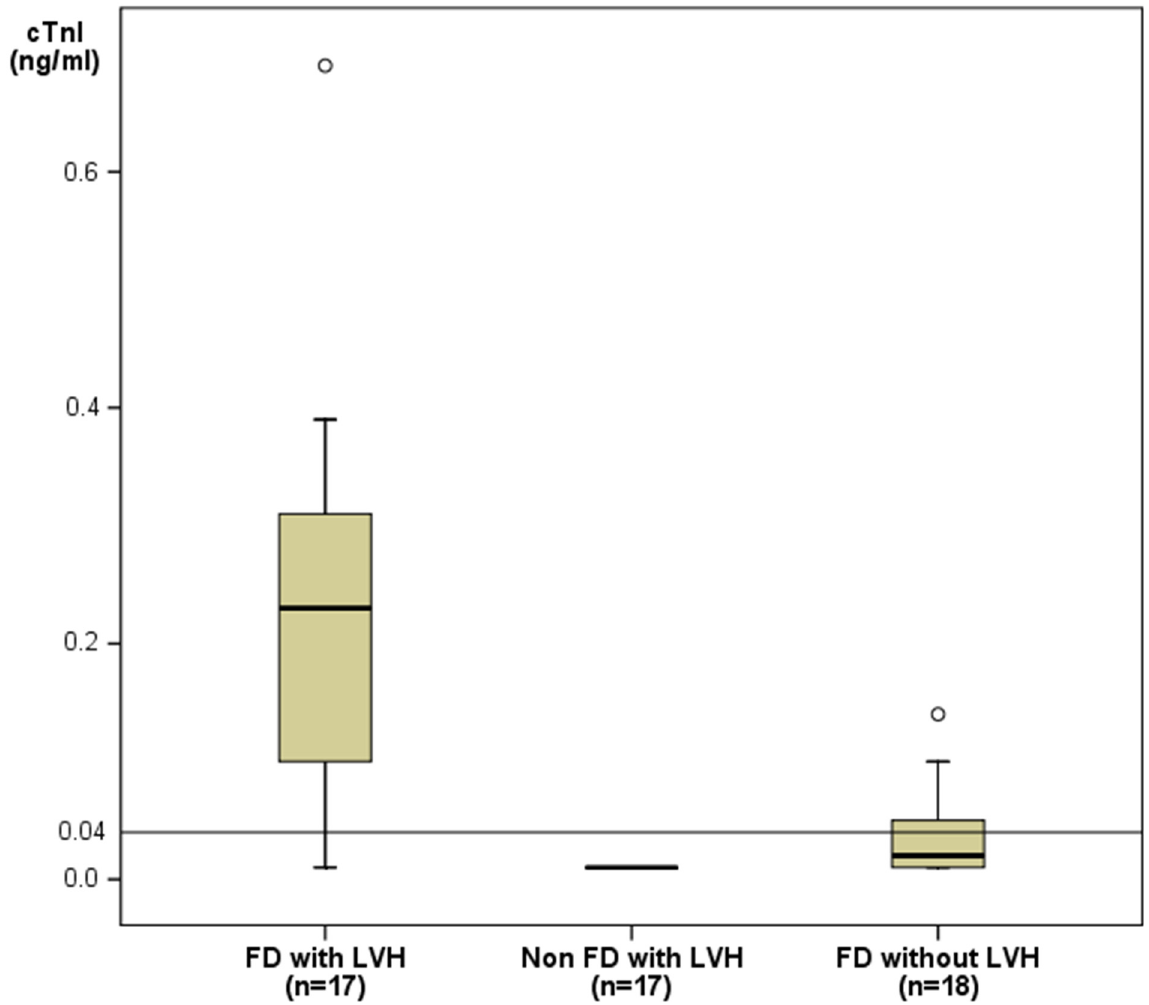
Fig 1. Comparison of cardiac troponin I levels. Presented are patients with Fabry disease (FD) and left ventricular hypertrophy (LVH) (n = 17) versus FD patients without LVH (n = 18) and non-FD patients with LVH of other cause (n = 17). The cut-off level for cTnI in diagnosing myocardial infarction ( (cid:1) 0.04 ng/ml) is indicated in the